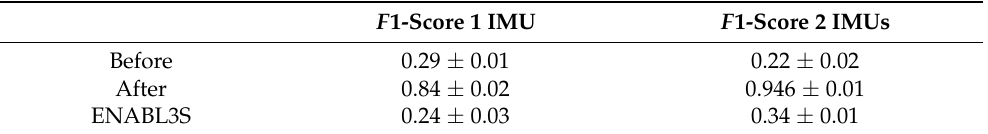
Table 7. F 1-scores with CNN-LSTM with 10 ENABL3S subjects. The row ‘Before’ represents results obtained without the independent subject data during training, while the row ‘After’ represents results obtained with the independent subject data during training. The row ‘ENABL3S’ shows results on ENABL3S data after retraining with MyLeg